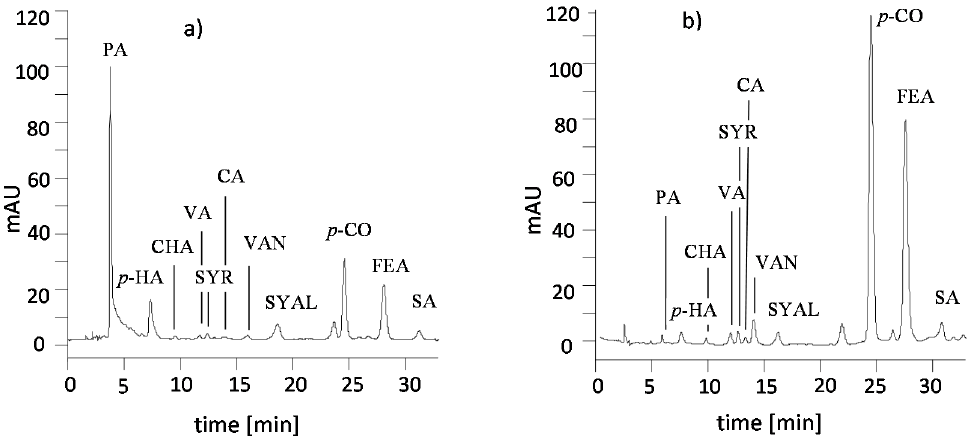
Figure 1. Selected RP-HPLC chromatogram of phenolic compounds of the extracts from hay: ( a ) following acid hydrolysis, ( b ) following alkaline re-hydrolysis.